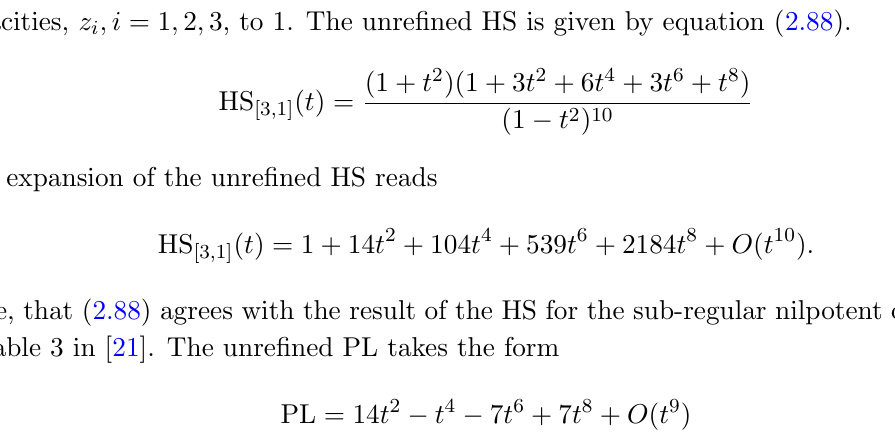
(4) quiver with G 2 global symmetry, dim M H [3 ; 1]